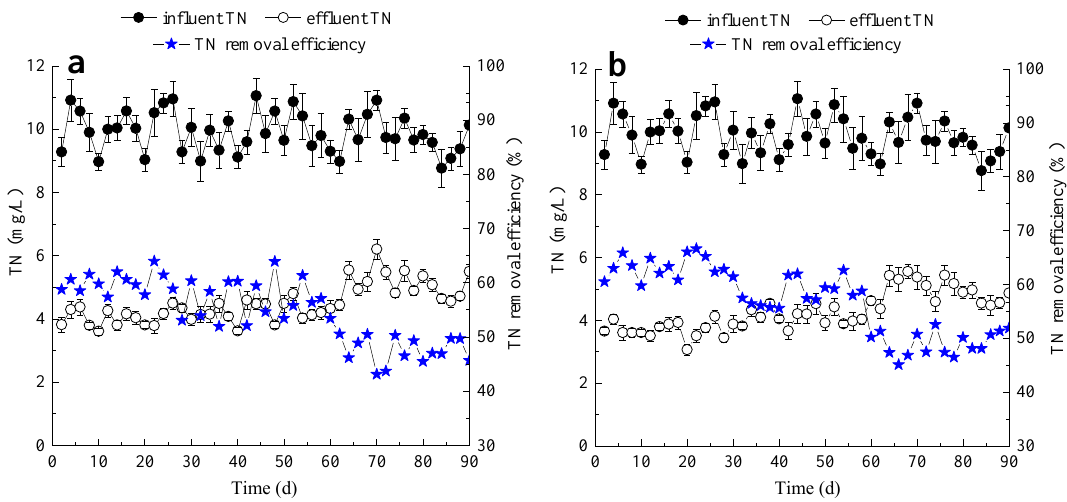
Figure 4. TN removal performances in the VFCW ( a ) and HFCW ( b ) ecosystems under different influent loads. The results were the averages and their standard deviations. The NO 3− −N removal performances of VFCW and HFCW ecosystems under different influent